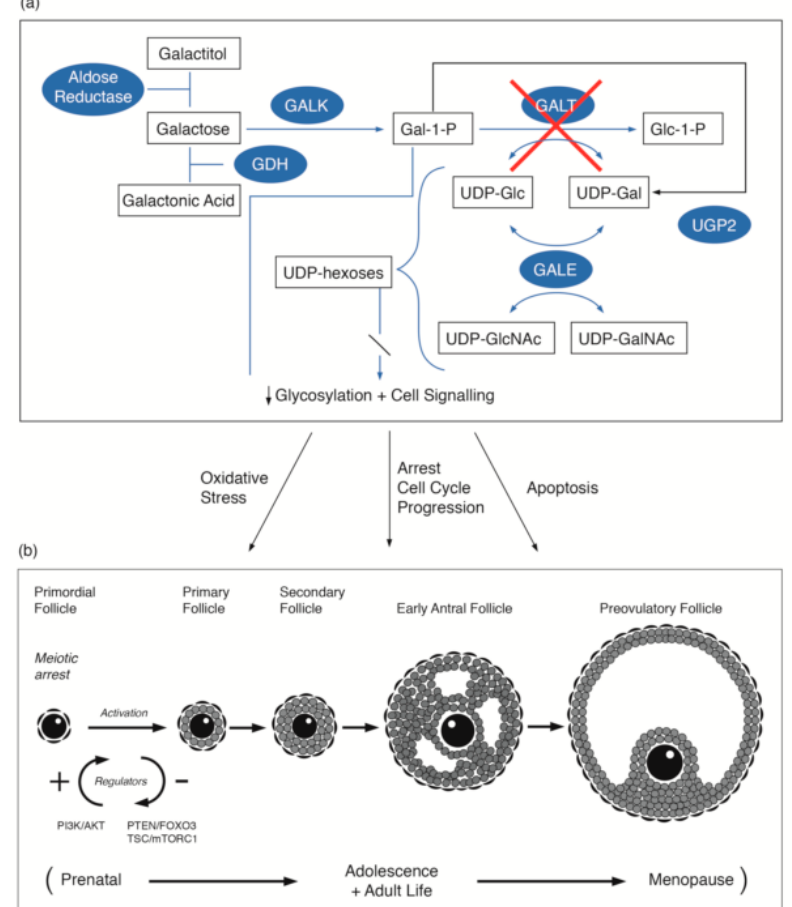
Figure 1. ( a ) Illustration of the pathways of galactose metabolism, with inhibition of the key enzyme: galactose-1-phosphate uridylytransferase. The key enzymes involved are shaded. ( b ) Illustration of the steps in oogenesis and folliculogenesis over the prenatal to menopause time period that may be influenced by GALT deficiency [16–20] with the proposed site of the PI3K / AKT regulation as cited by Sanchez and Smitz [20]. The abbreviations used are listed in the abbreviations list.